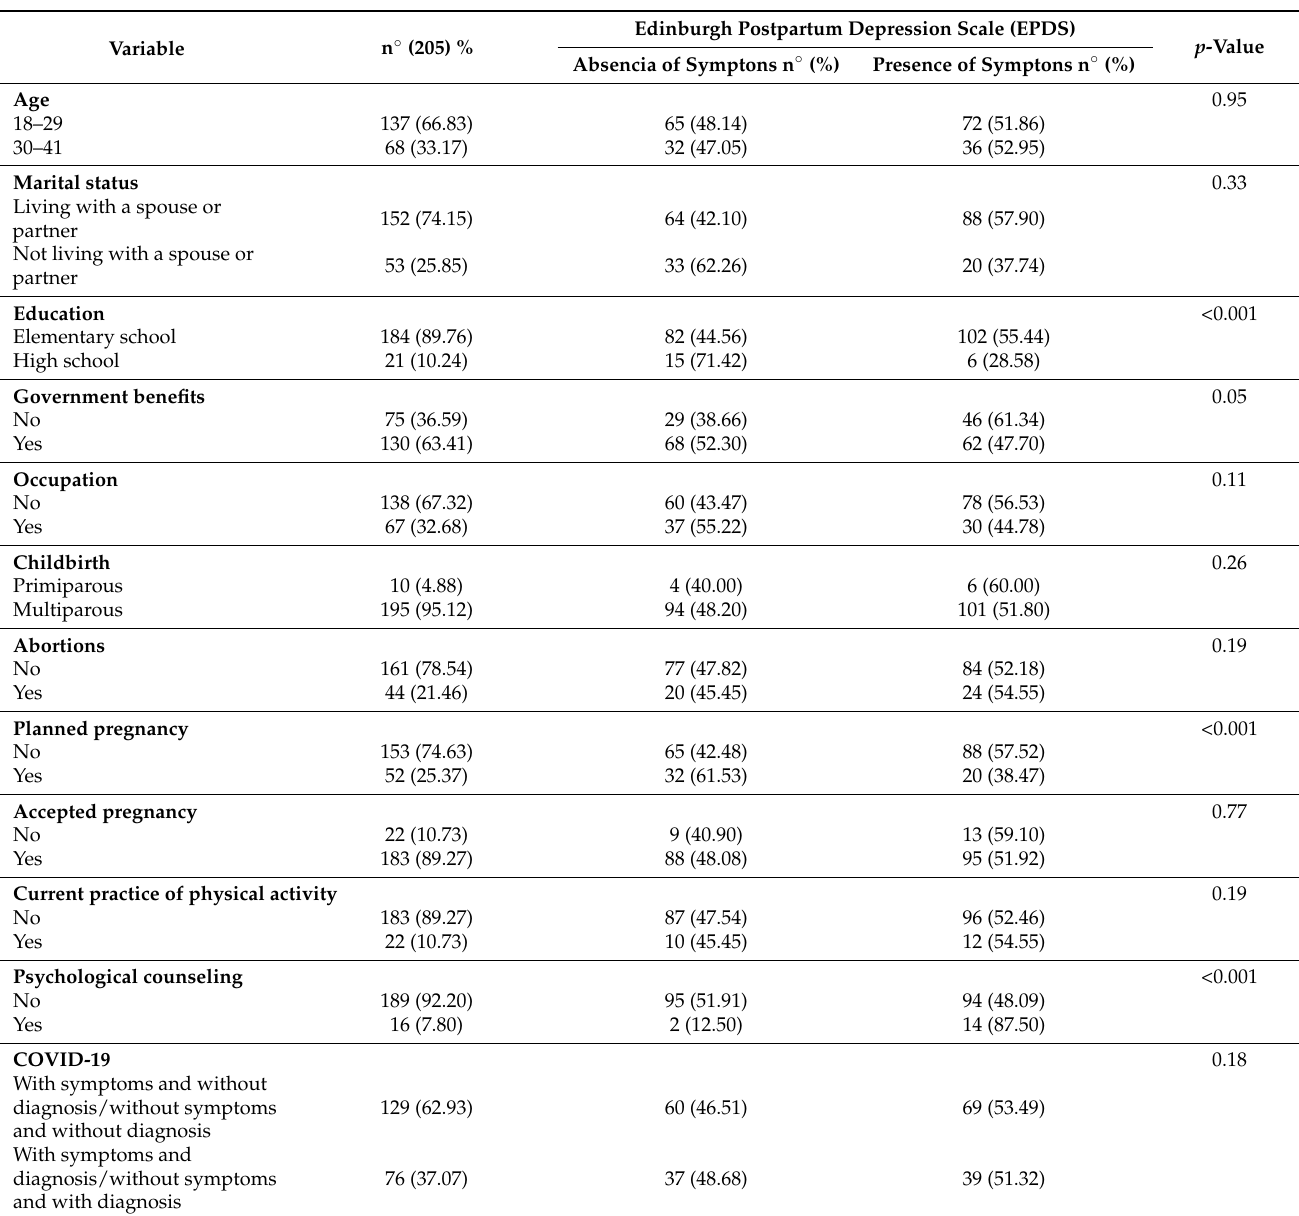
Table 1. Distribution of sociodemographic, demographic, lifestyle, and reproductive variables and depressive symptoms of pregnant women followed up with during prenatal care at basic health units in S ã o Lu í s City, Maranh ã o State, Brazil, in